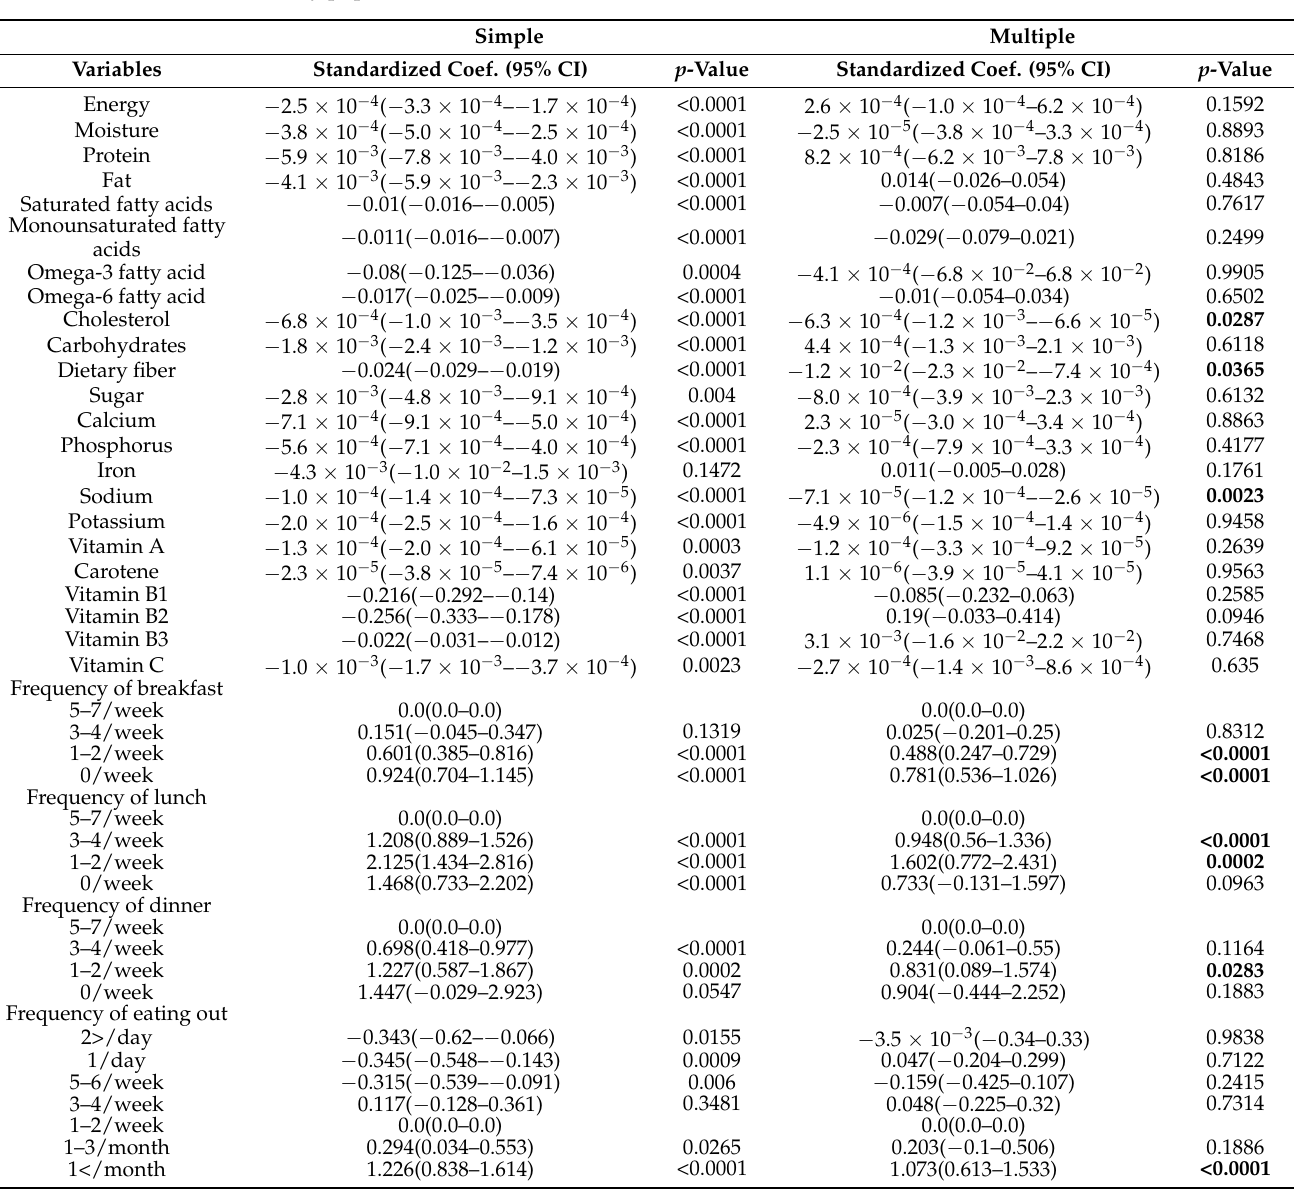
Table 2. The results of univariate simple and multiple linear regression for nutrient intake and dietary habits as they relate to PHQ-9 scores of the study